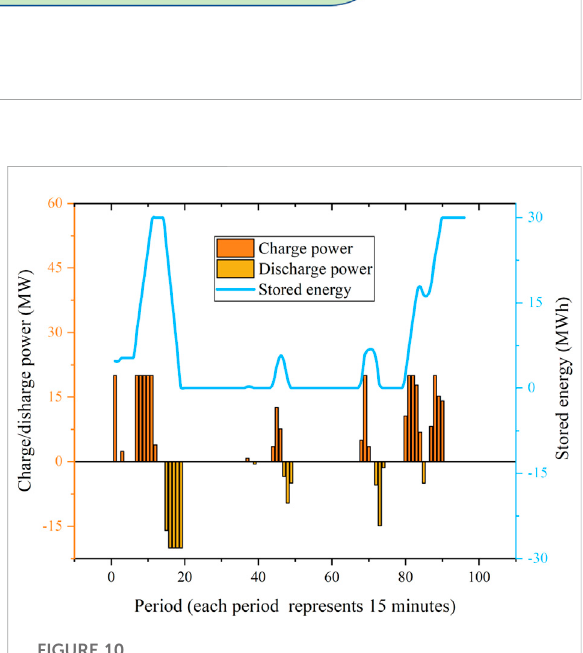
FIGURE 10 ESS ’ s charge power, discharge power, and stored